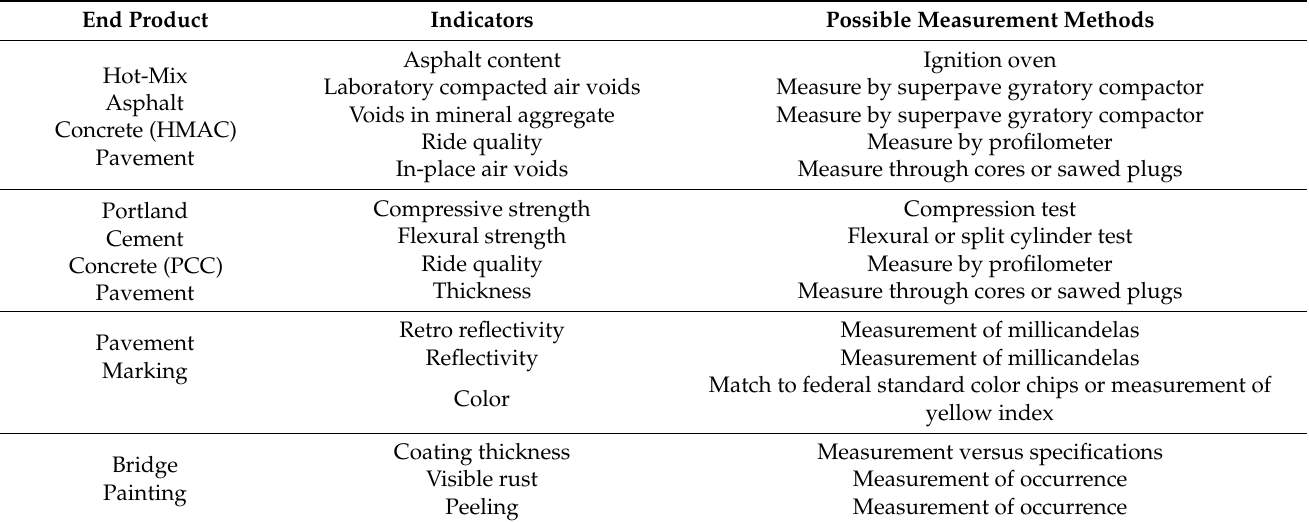
Table 1. Construction quality performance measurement indicators.